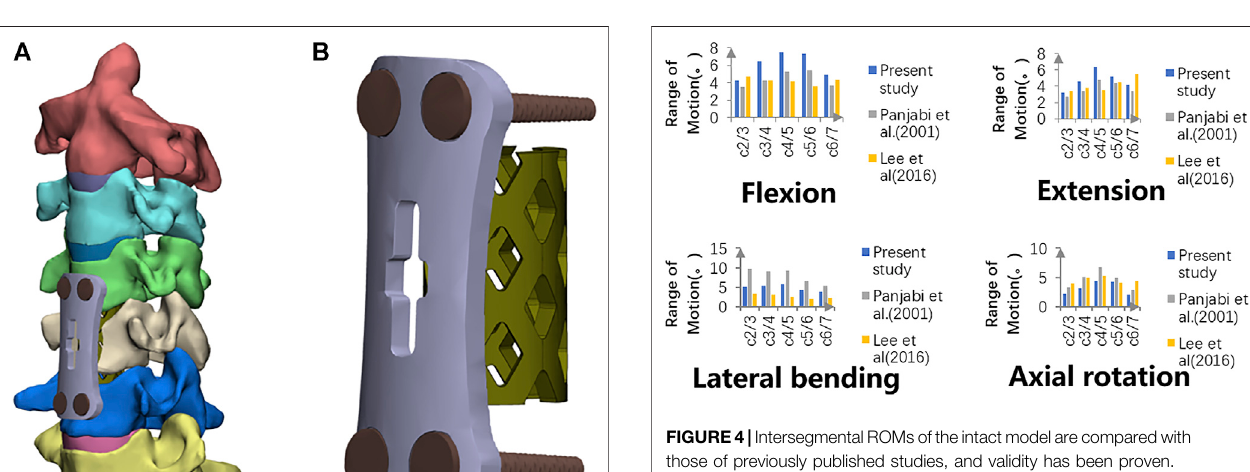
Frontiers in Bioengineering and Biotechnology |